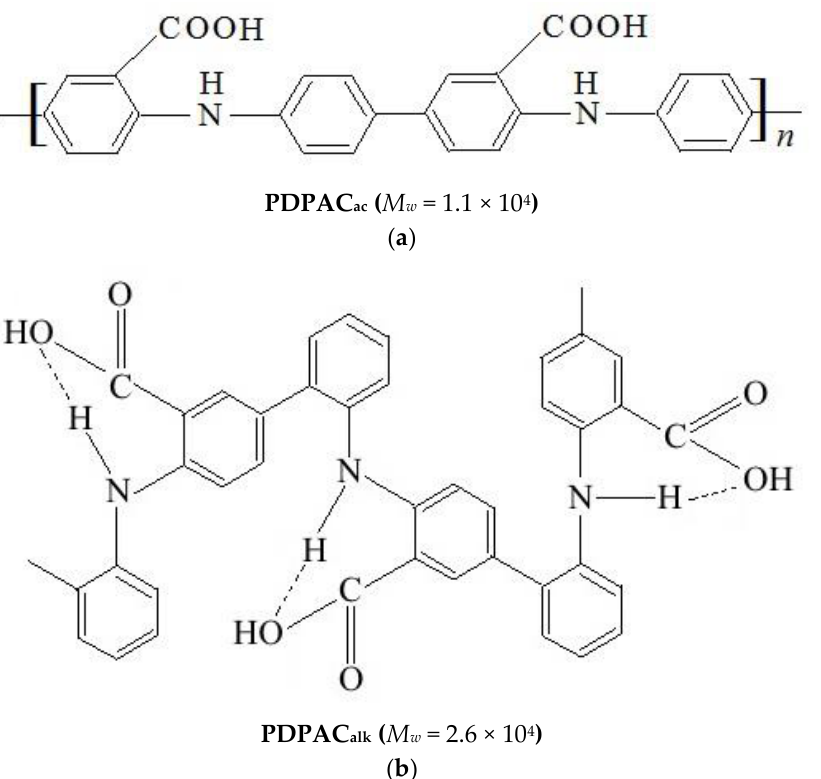
Figure 1. The chemical structure of PDPAC polymers prepared in 5 M H 2 SO 4 ( a ) and in an NH 4 OH solution in the presence of chloroform ( b ).